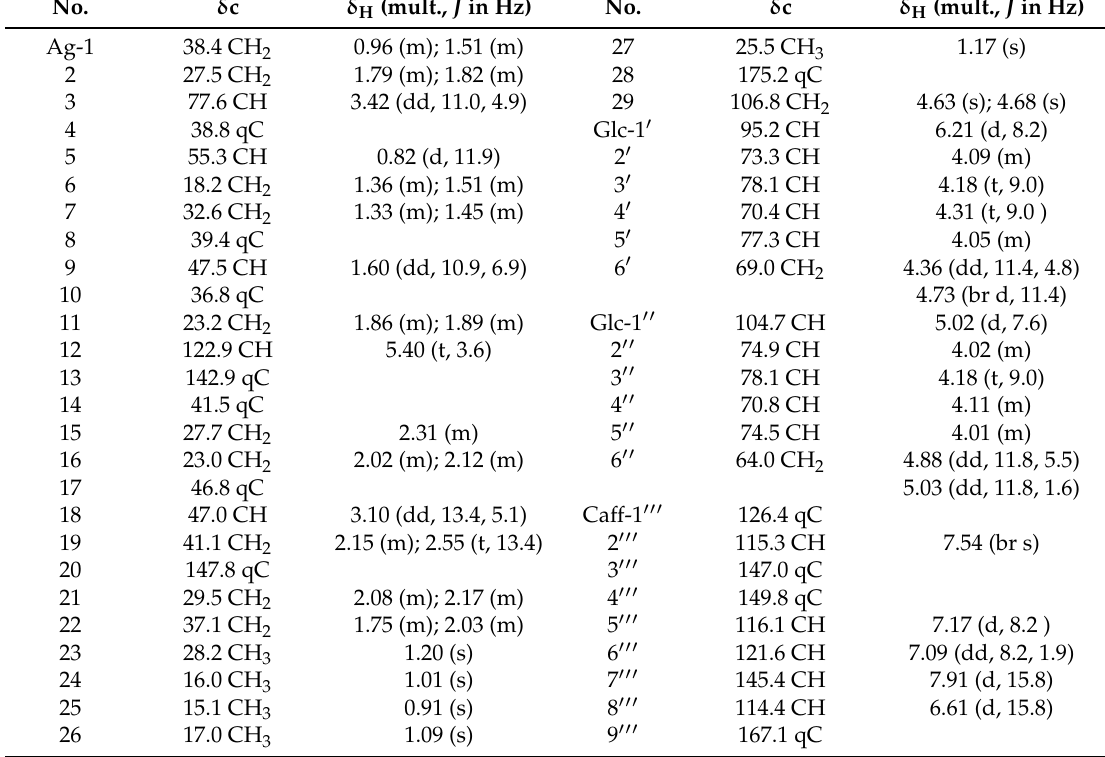
Table 2. NMR spectroscopic data for compound 2 in pyridine- d 5 .